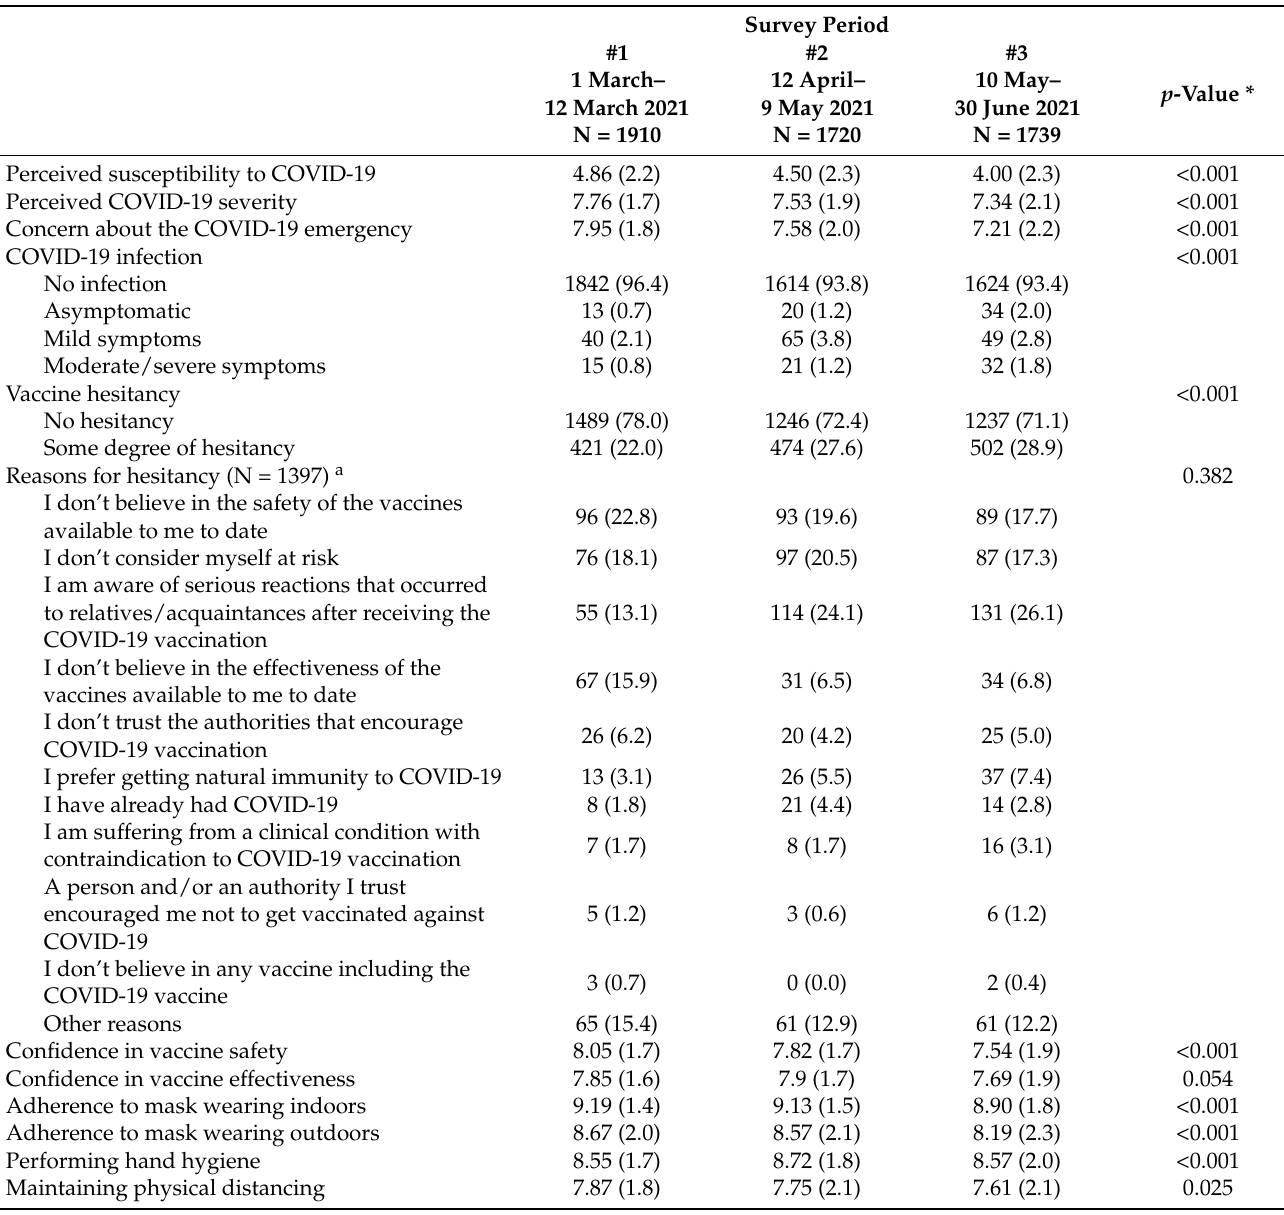
Table 2. Students’ COVID-19 experience, risk perceptions, attitudes towards SARS-CoV-2 vaccination, and self-reported adherence to precautionary measures by survey period. Results are expressed as mean (standard deviation) or frequency